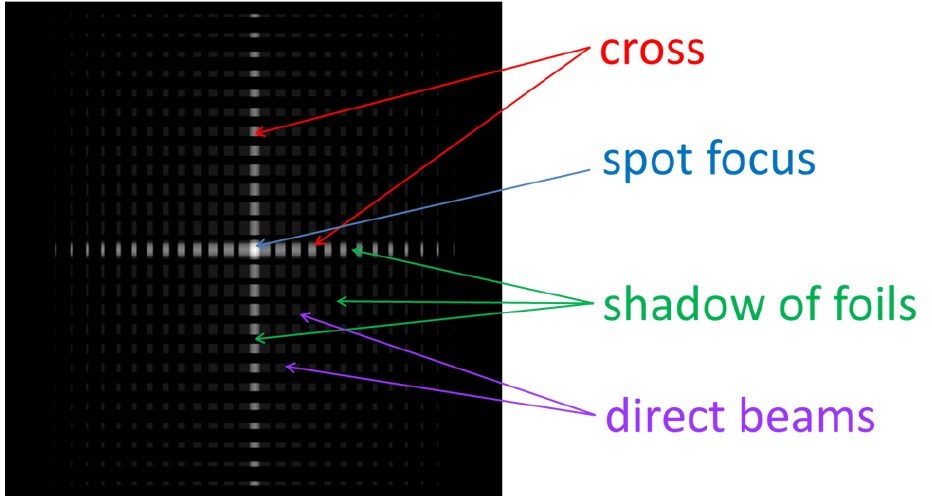
Figure 5. LE imaging performance principle. Optics creates main cross with spot focus (twice reflected rays) and also only once, as well as nonreflected direct beam photons. Off-axis source within declared FOV moves image out of center of